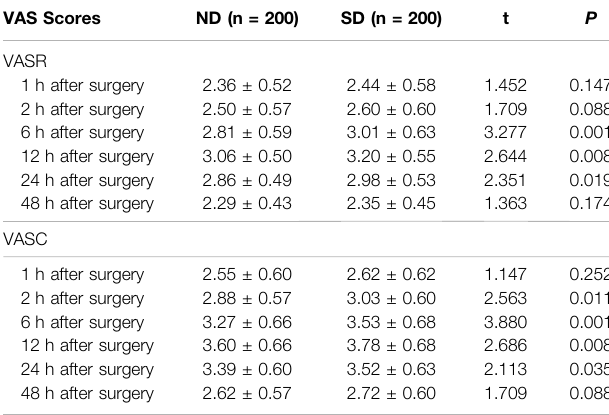
TABLE 4 | VAS scores of children at 1, 2, 6, 12, 24, and 48 h after arrival to the ward between Group ND and Group SD. VAS Scores ND (n = 200) SD (n = 200) VASR 1 h after